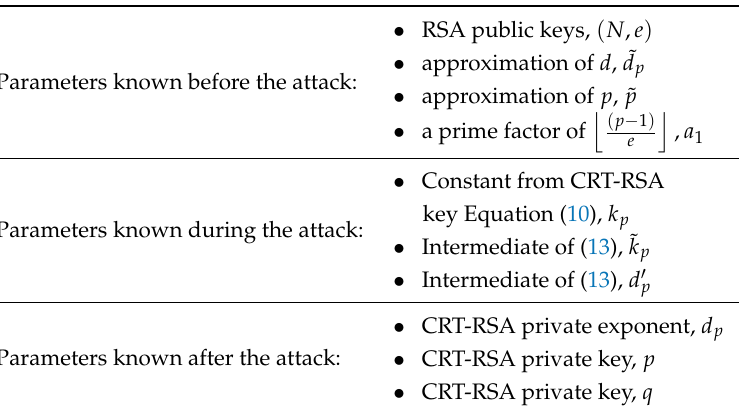
Table 1. List of Parameters Used in the